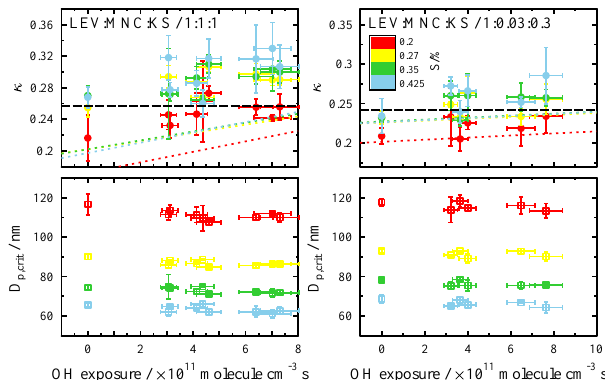
Figure 8. Derived κ (top) and critical particle diameter (bottom) for the ternary-component particles with LEV:MNC:KS mass ratios 1 : 1 : 1 (left) and 1 : 0 . 03 : 0 . 3 (right) are shown as a function of OH exposure. As indicated in the legend, the colors represent the different supersaturations ( S ) accessed during this study. The dashed black lines are calculated as in Fig. 7 and error bars and dotted lines are calculated as in Figs. 6 and 7,